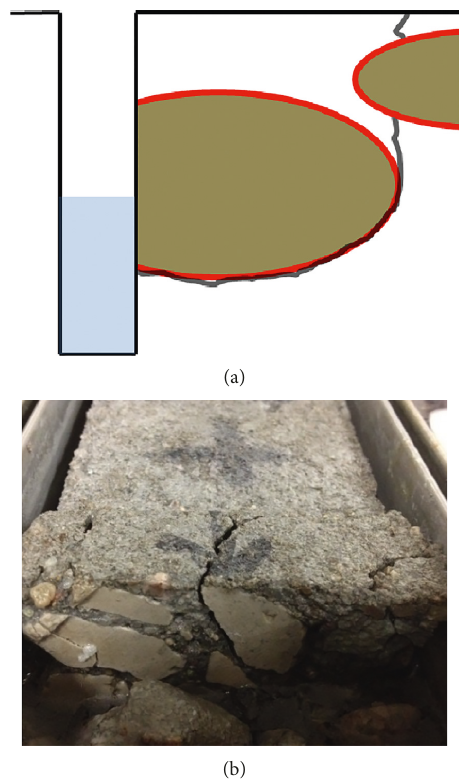
Figure 11: Crack developing out of a saturated ITZ. (a) Schematic sketch of the theory. (b) Laboratory observation supporting the